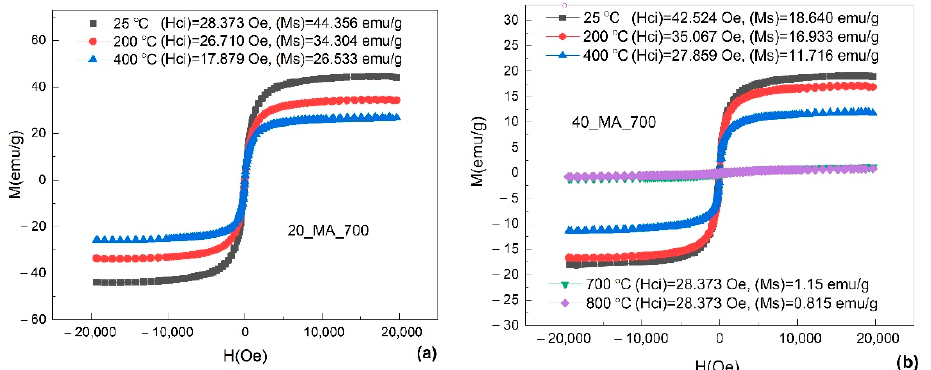
Figure 2. Magnetic hysteresis loops for two samples, at different temperatures: ( a ) 20_MA_700 at three temperatures: 25 °C, 200 °C and 400 °C and ( b ) 40_MA_700 at 25 °C, 200 °C, 400 °C, 700 °C and 800 °C.